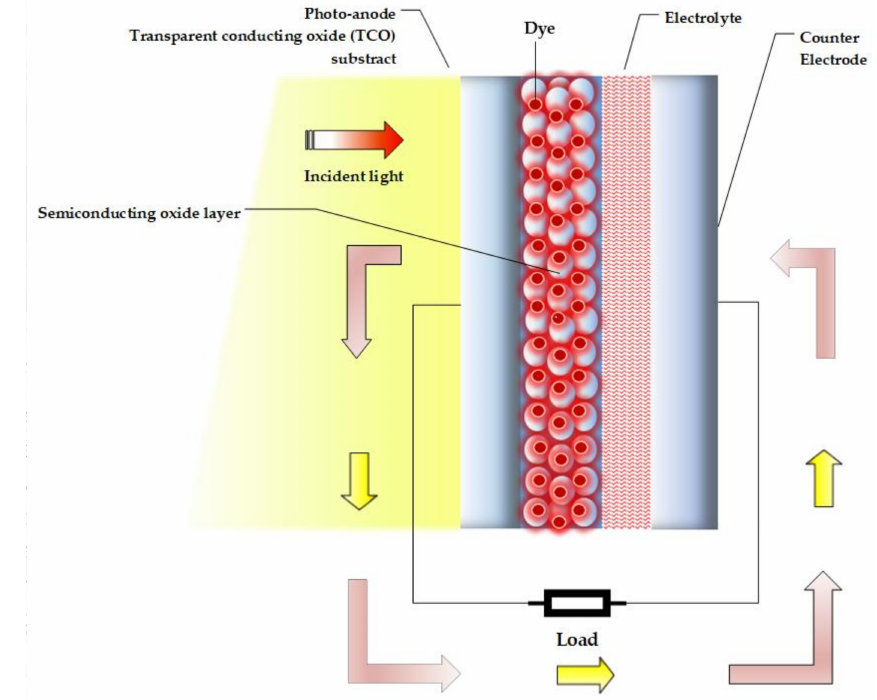
Figure 1. Diagram of the structure of a DSSC (based on